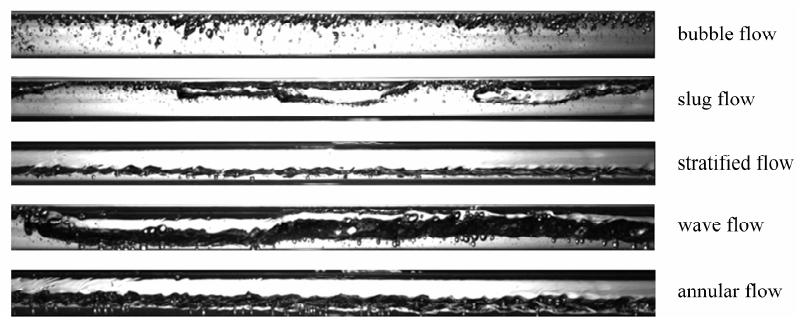
Figure 3. High-speed photos obtained by the highspeed camera.